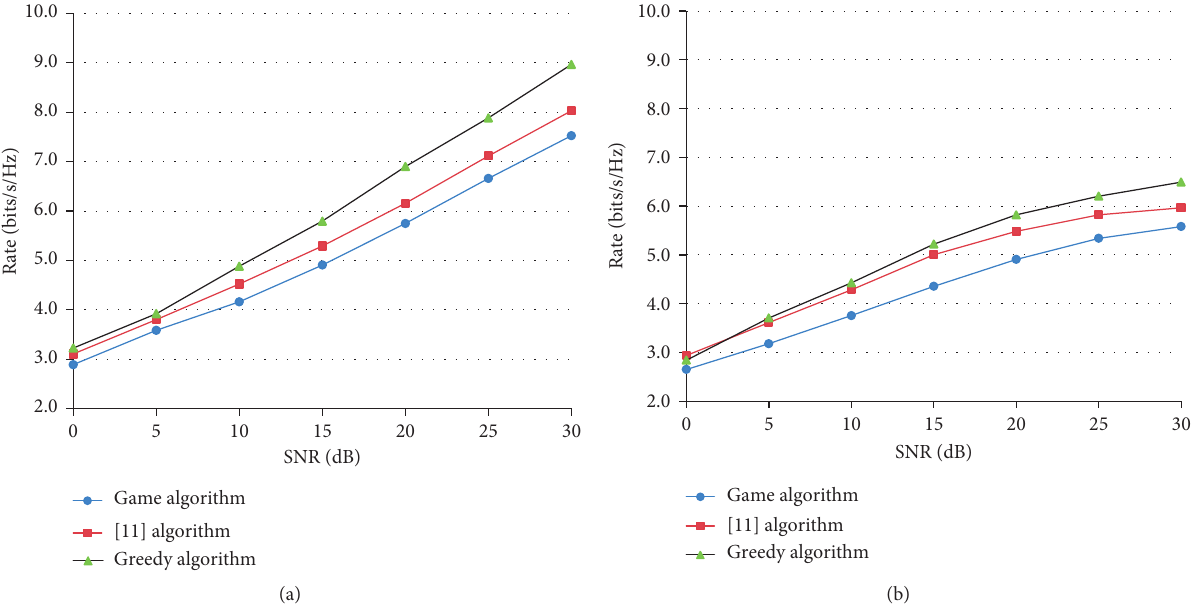
Figure 4: Cellular user and D2D throughput to users. (a) Cellular user. (b) D2D